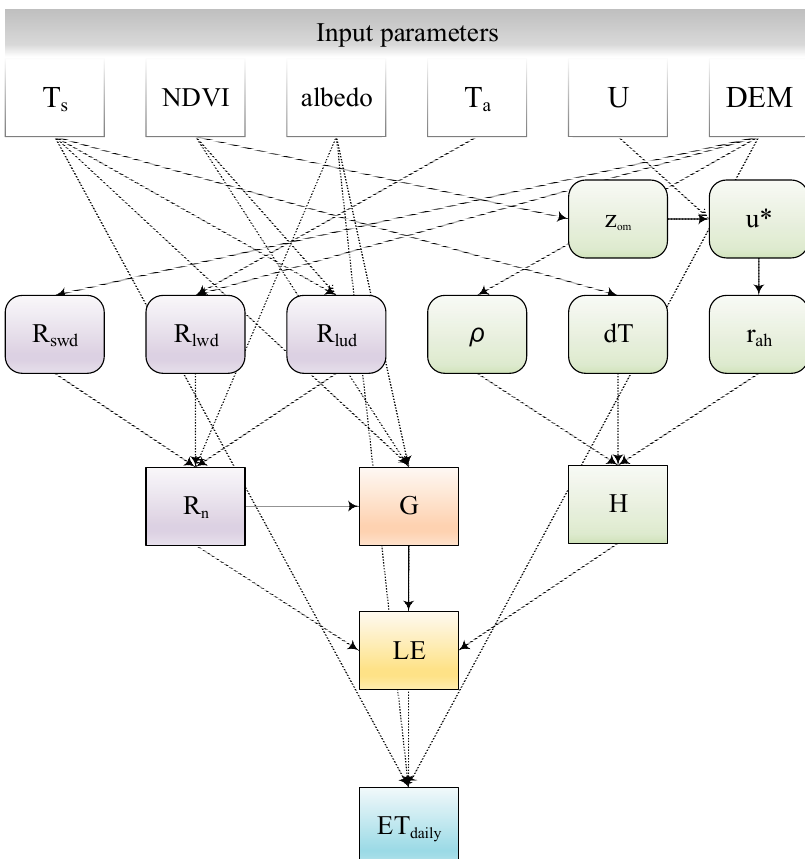
Figure 2. Flowchart for the Surface Energy Balance Algorithm for Land (SEBAL) model algorithms. NDVI is normalized difference vegetation index, ET is evapotranspiration, and LE is latent heat flux.